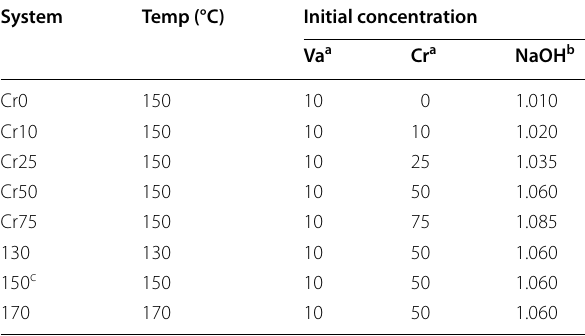
Table 1 Reaction systems employed in this